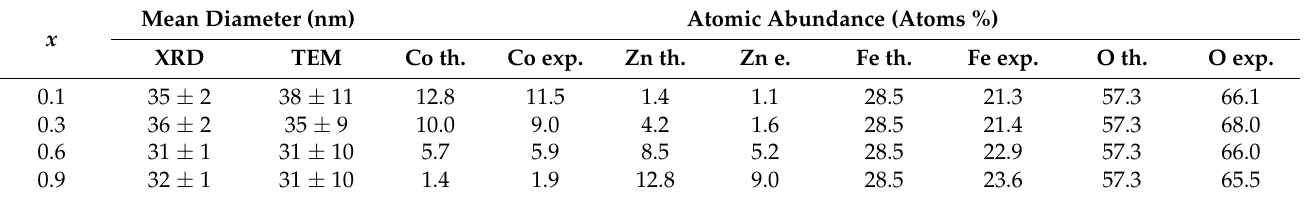
Figure 2. TEM images of Co 1 − x Zn x Fe 2 O 4 nanoparticles. Table 2. Average Co 1 − x Zn x Fe 2 O 4 nanoparticles’ size determined from XRD and TEM investigations, and atomic elemental composition theoretically calculated and determined from EDS measure- ments.